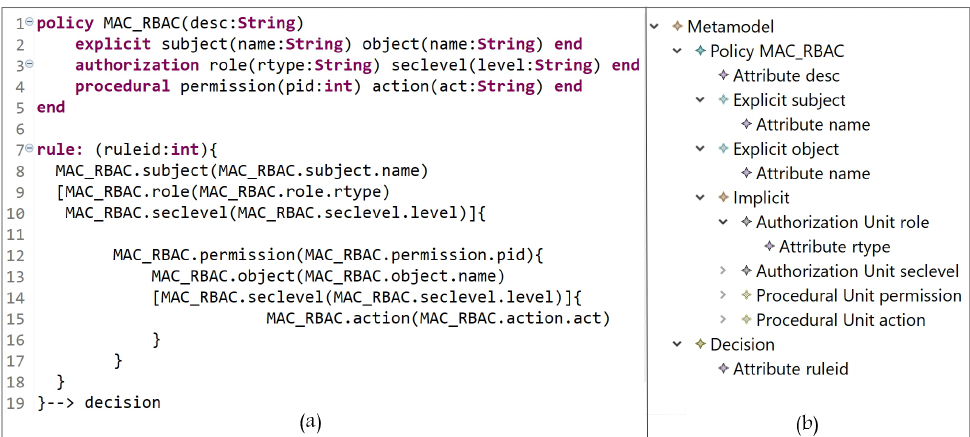
Figure 15. ( a ) MAC/RBAC policy definition; ( b ) MAC/RBAC